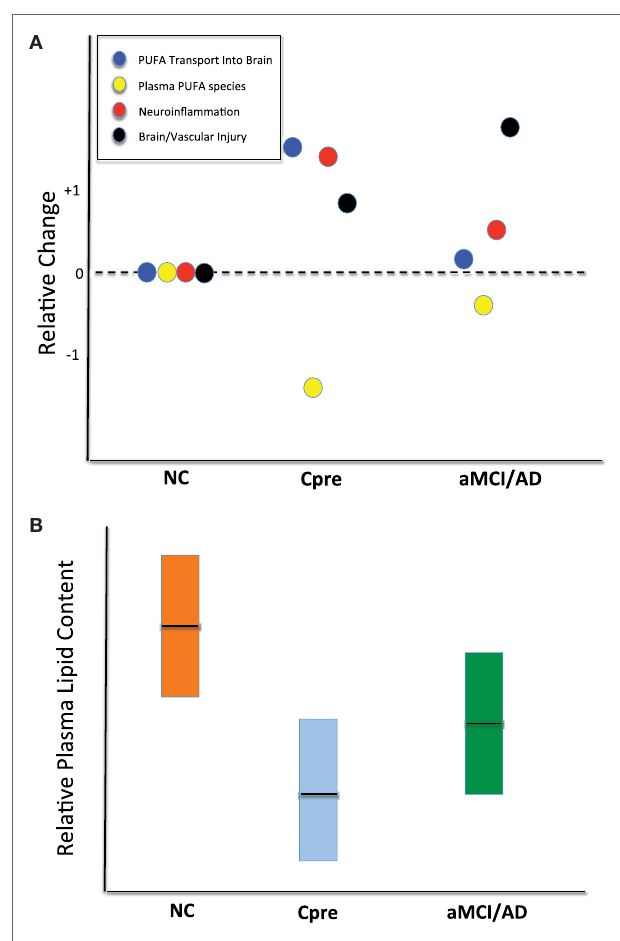
FigUre 5 | schematic representations of potential alterations within brain and peripheral blood responsible for reduced plasma phospholipid levels . (a) Qualitative dot plot of differential changes occurring in cognitively normal control (NC), cognitively normal Converter pre (C pre ) subjects, and those with amnestic mild cognitive impairment or Alzheimer’s disease (aMCI/AD). Note that all four processes (represented within boxed legend) are at the zero relative level in the NC subjects. The C pre subjects could show significant polyunsaturated fatty acid (PUFA) transport into brain to replenish lost substrate as a result of neuroinflammation or other brain injury. The increase in PUFA flux into the brain is an attempt to compensate for ongoing injury and results in a marked reduction in the plasma levels of molecules carrying those lipid species. Dark horizontal line within boxes represents proposed mean. (B) Qualitative plasma phospholipid biomarker results, previously quantified (2), which may be better interpreted via the theory proposed in (a) . Dark horizontal line within boxes represents proposed mean. The full explanation for this metabolic phenomenon in the C pre subjects remains to be